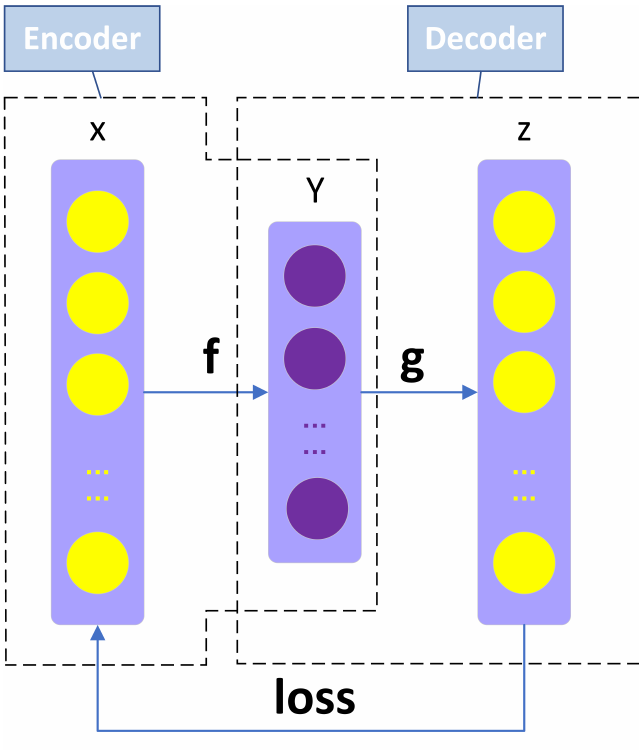
Figure 1. Schematic diagram of auto-encoder